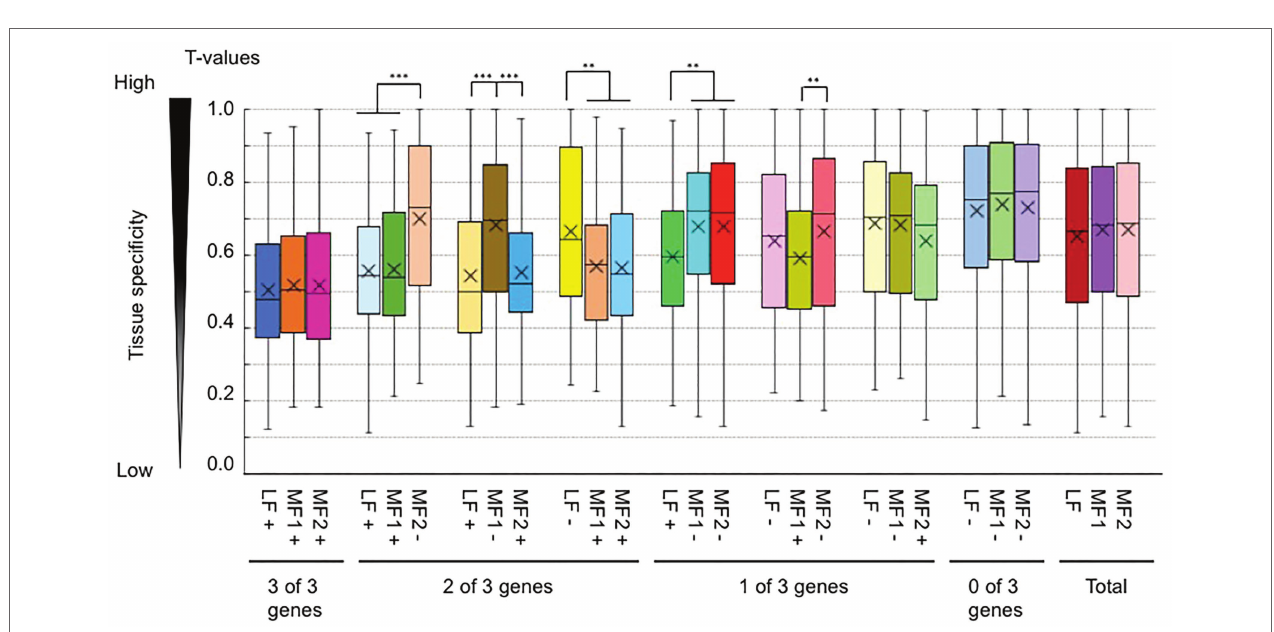
FIGURE 7 | Comparison of the expression level (FPKM) between paralogous pairs with and without H3K36me3 marks in RJKB-T23. Values are means ± standard error (s.e.) of FPKM. “+” and “ − ” represent the presence and absence of H3K36me3 marks, respectively. * p < 0.05; ** p < 0.01; *** p < 0.001 (Student t -test).